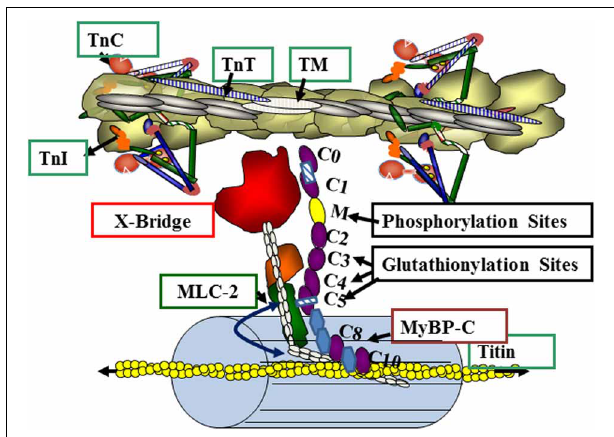
FIGURE 6 | Myosin binding protein C (MyBP-C) interactions in the overlap region of the sarcomere. The illustration depicts a relaxed state with troponins (TnC, TnT, TnI) and tropomyosin (TM) blocking the actin-cross-bridge reaction. Myosin light chain 2 (MLC2) and MyBP-C contribute to radial movements of the myosin heads relative to the thick filament backbone (as indicated by the double headed arrow). MyBP-C has interaction sites via theM domain with the neck region of myosin (S2) and with titin via C-terminal domains C8, C9 and C10. MyBP-C may also interact directly with the thin filament. See text and results for